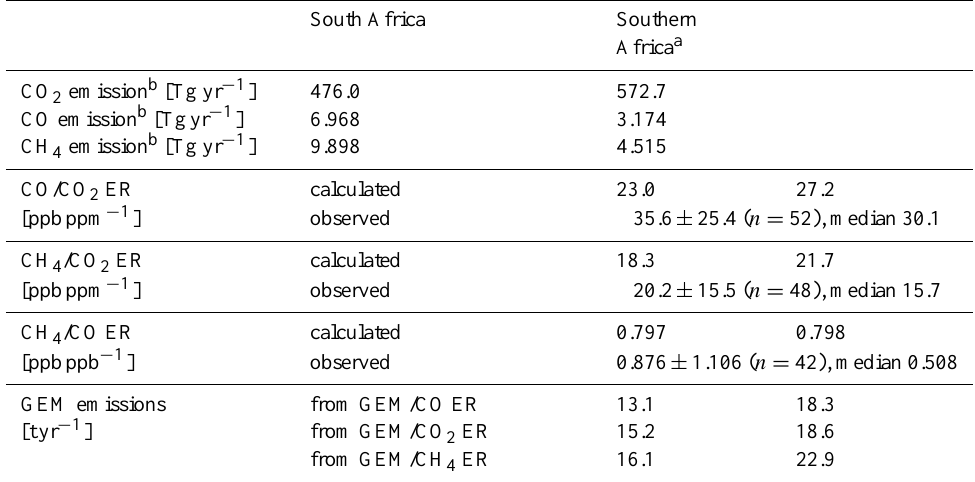
Table 3. Comparison of CO/CO 2 , CH 4 /CO 2 , and CH 4 /CO emission ratios from observations and from EDGAR inventory and GEM emis- sions calculated from GEM/CO, GEM/CO 2 , and GEM/CH 4 emission